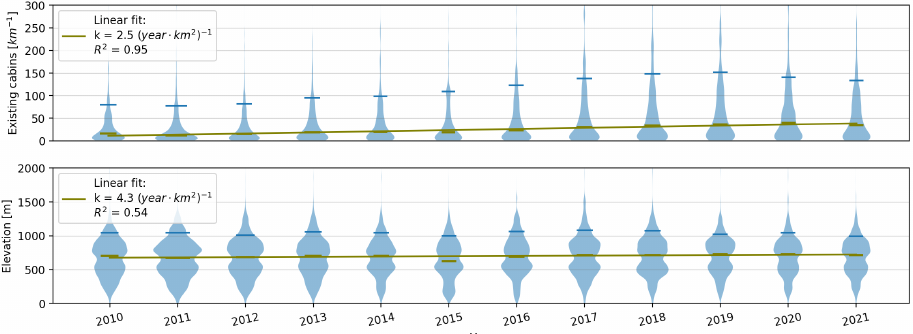
Figure 9. Distribution of alpine cabins built per year since 2010 to 2021 based on the location of existing cabins (km − 1 ) ( top ) and elevation m above sea level ( bottom ). Green lines: medians and the trend. Blue lines show 90th